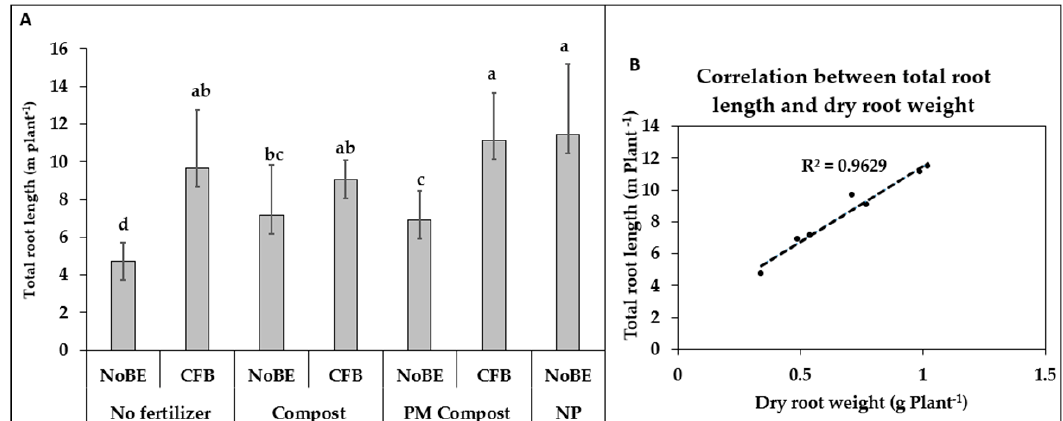
Figure 3. Total root length ( A ) and root length correlation with dry root biomass ( B ) of 7-week-old tomatoes on pH 7.8 soil. (CFB = Combifector B, PM = Poultry manure, NP = calcium nitrate plus superphosphate. Means and SE of five replicates. Significant treatment differences are indicated by different letters (T-grouping (LSD) at p = 0.05). * = significant difference compared with the non-inoculated control (NoBE) within the same fertilizer treatment ( t -test at p < 0.05).